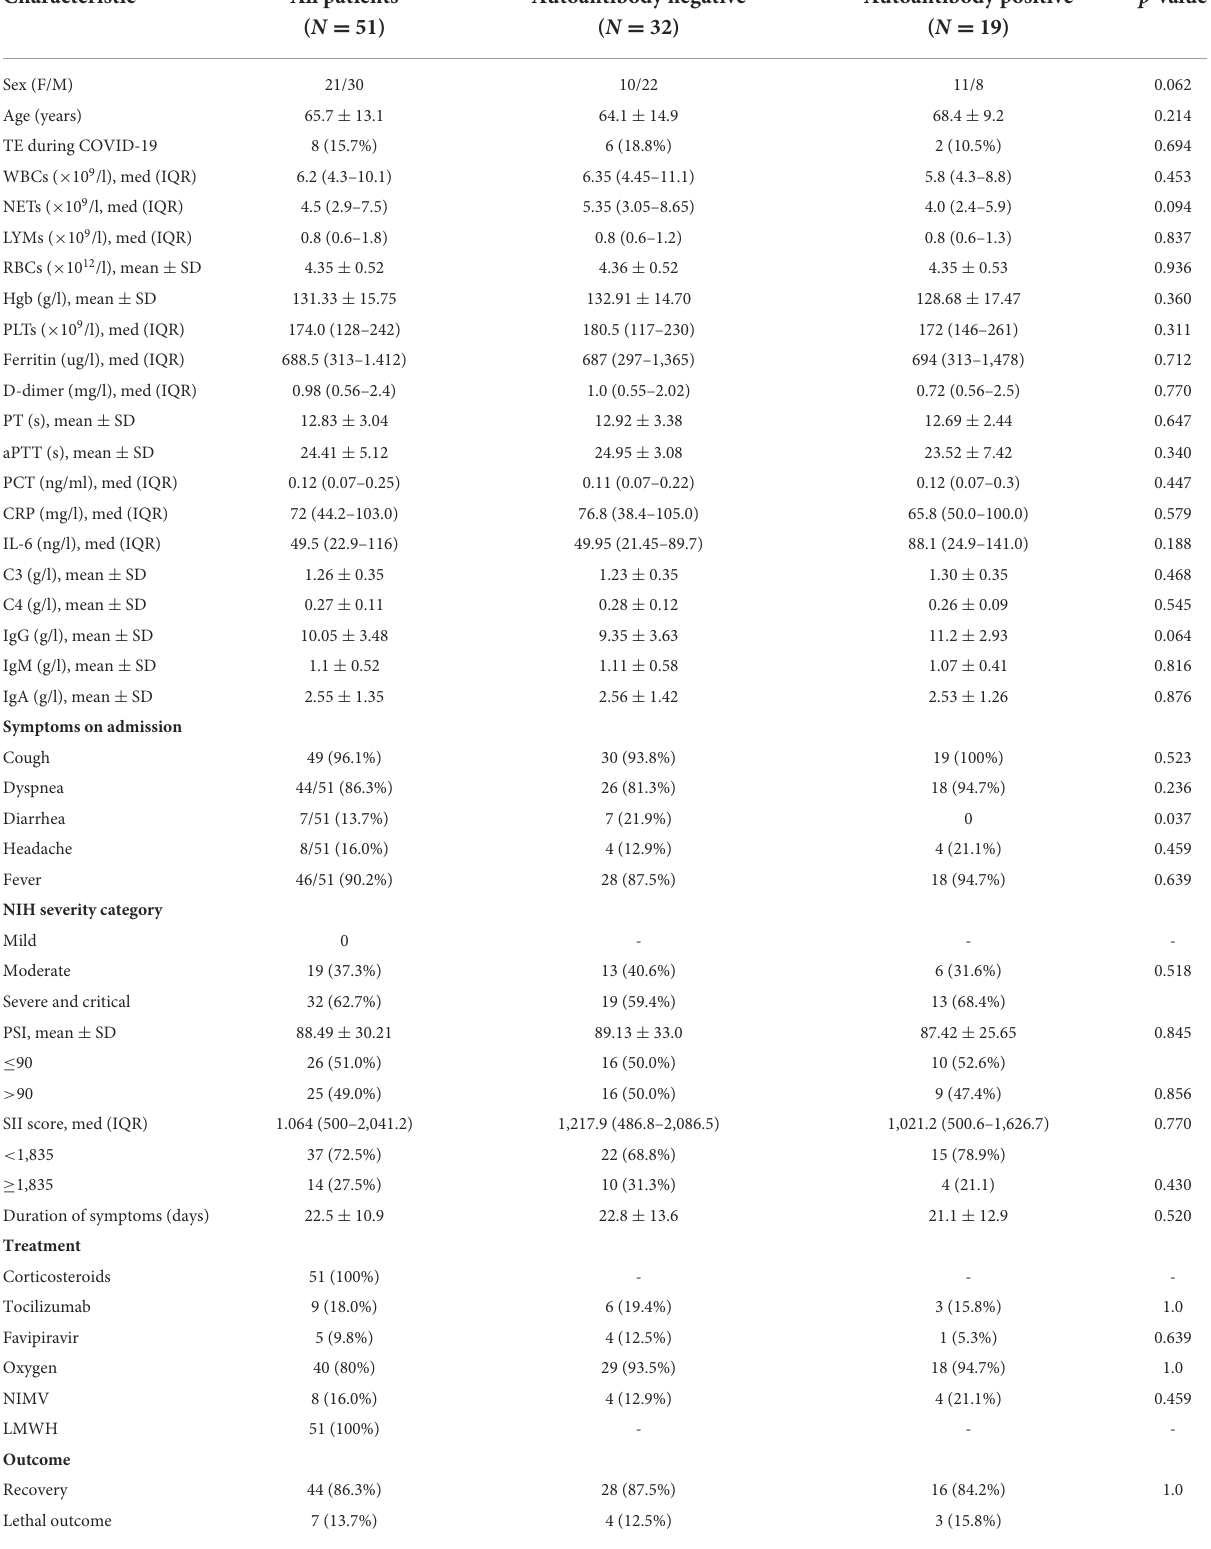
TABLE 2 Characteristics of patients according to the presence of